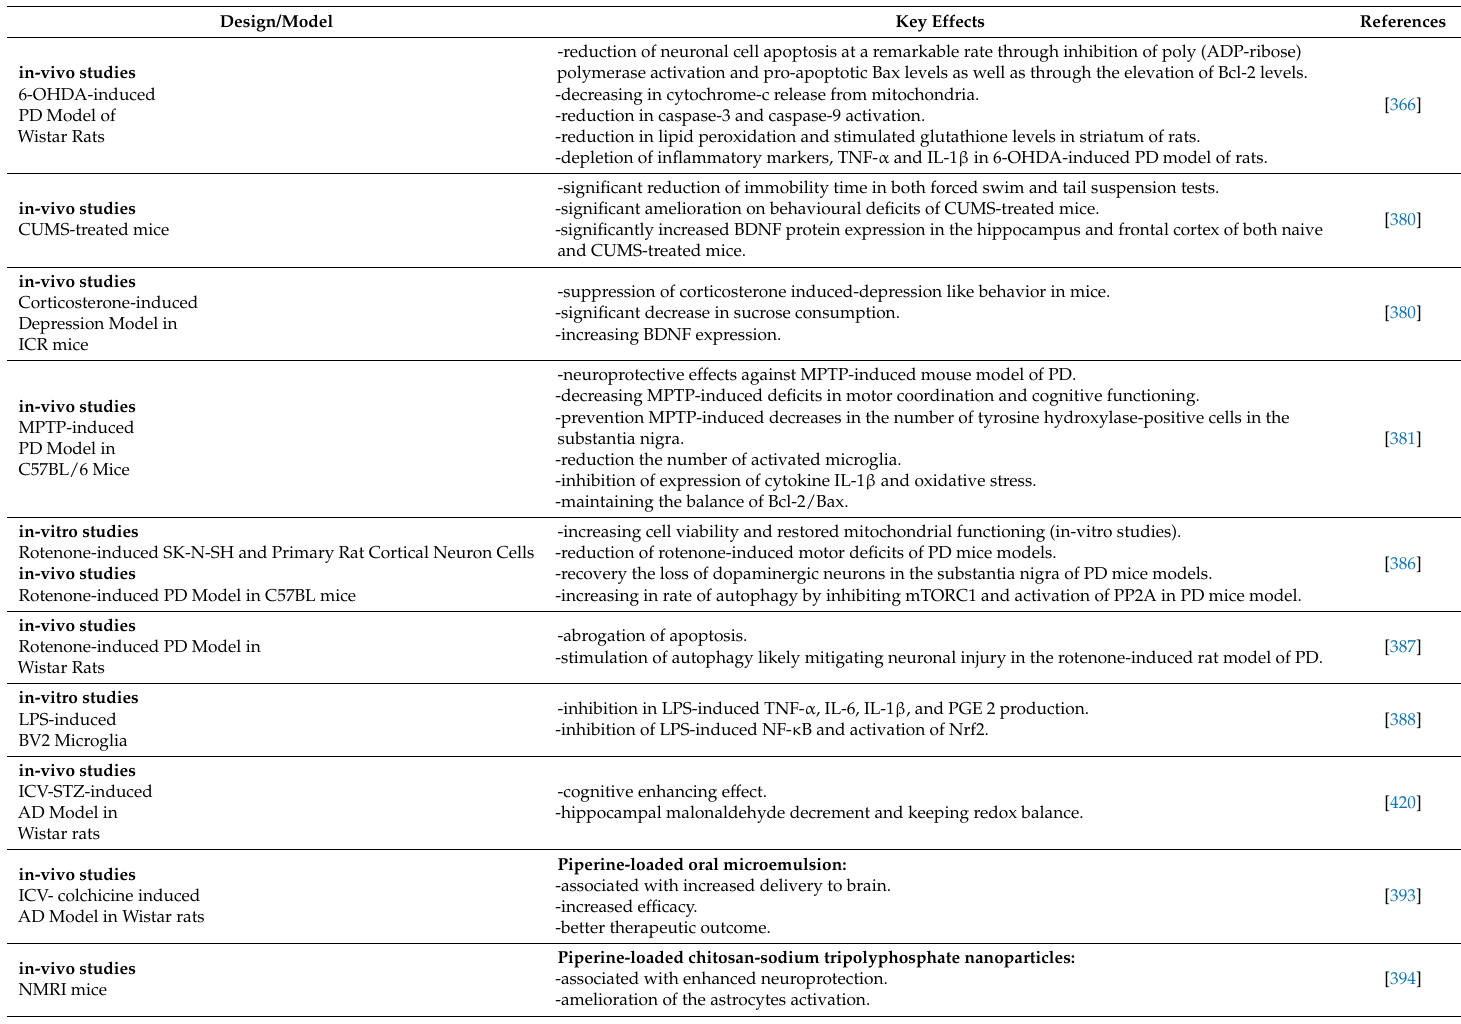
Table 33. Neuropharmacological activities of piperine as one of the active compounds of Piper